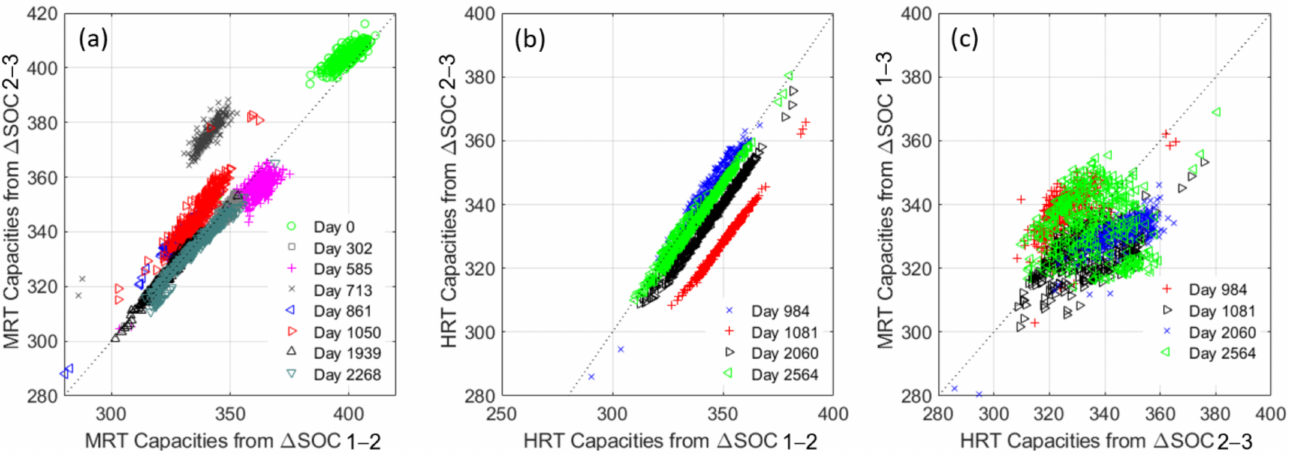
Figure 11. ( a ) MRT capacities calculated from ∆ SOC 1–2 vs. ∆ SOC 2.3, ( b ) HRT capacities calculated from ∆ SOC 1–2 vs. ∆ SOC 2–3, and ( c ) capacities HRT calculated from ∆ SOC 2–3 vs. MRT calculated from ∆ SOC 1–2. All calculations were performed using the initial OCV vs. SOC curve.